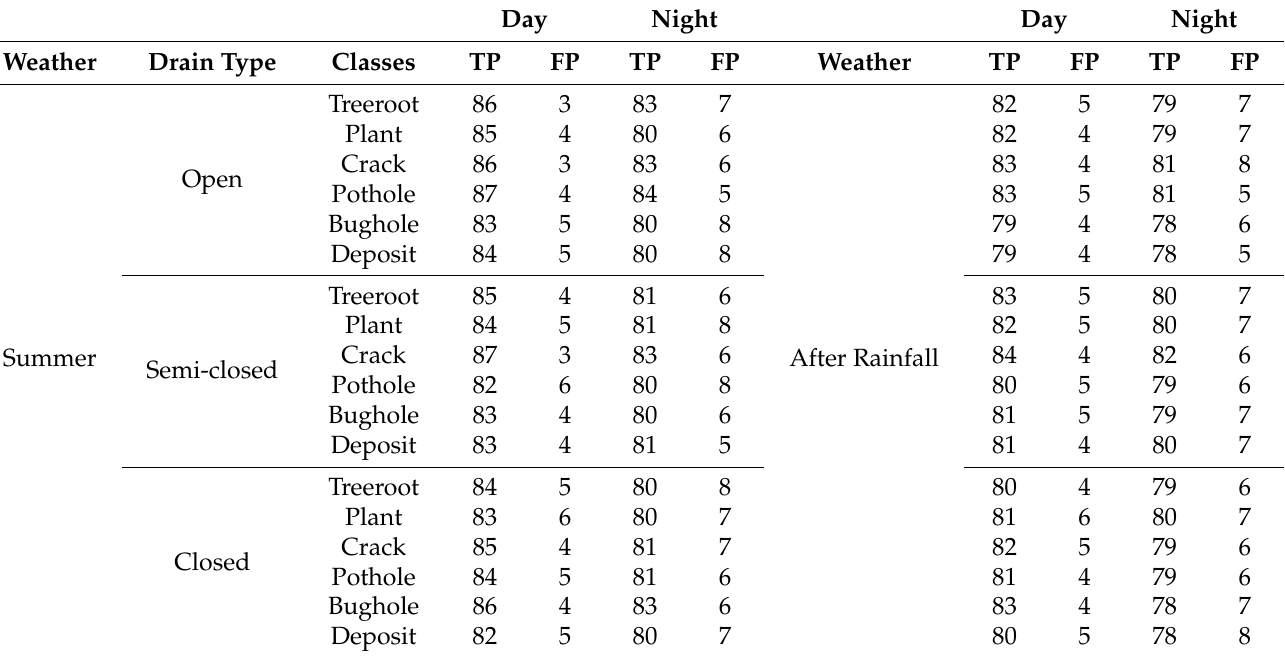
Table 5. Faster RCNN Inception-ResNet-v2 true positives and false